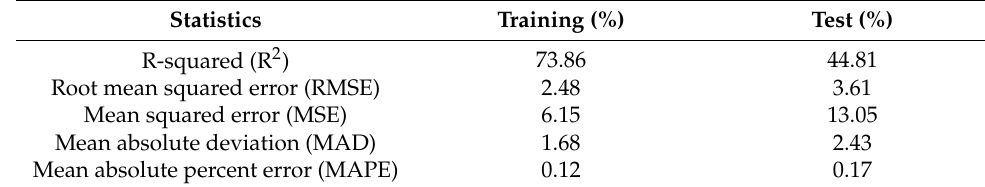
Table 6 lists the selected statistical parameters for the training and test datasets in the M f predictive model. These results were based on the six predictors, including three wood attributes ( M i , w i , and ρ b ) and three drying parameters (schedule, conditioning, and post-storage). The optimal performance (Figure 9) was achieved by having 550 trees in the model. The predictive model had an R 2 of 73.86% and 44.81% for the training and test, respectively. Table 6. Model summary for predicting the M f using TreeNet including six inputs.